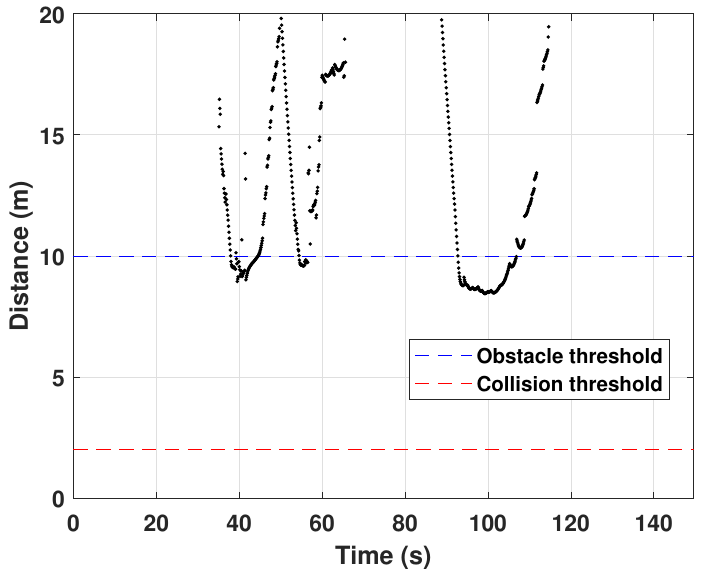
Figure 14. Case 3: Relative